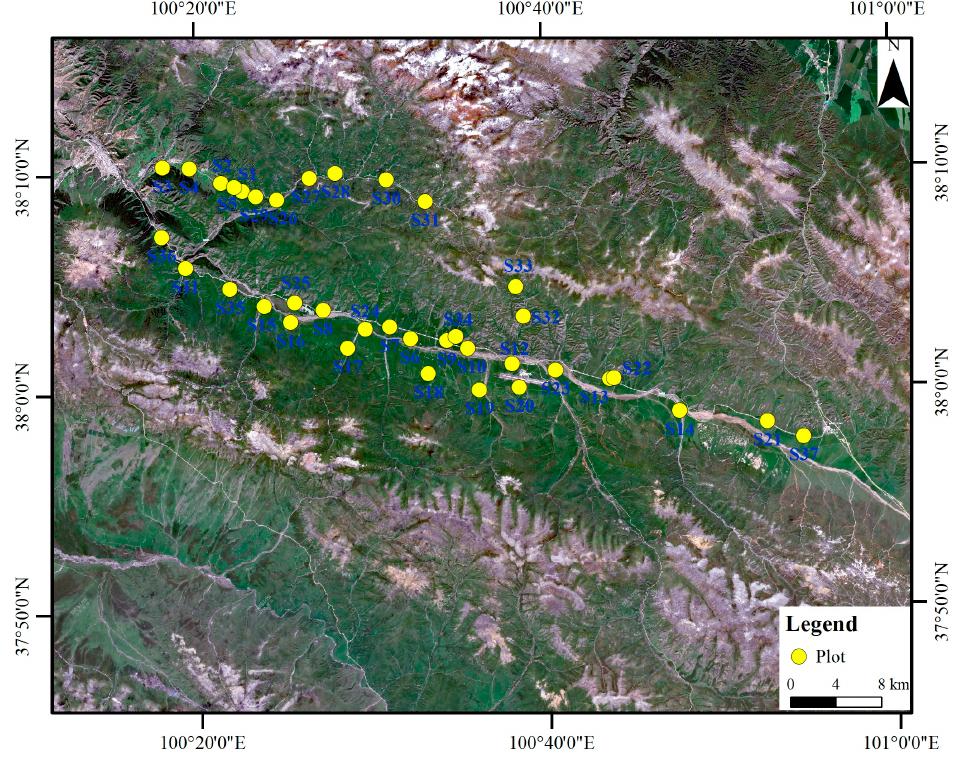
Figure 3. Sampling plots distribution in the study area.